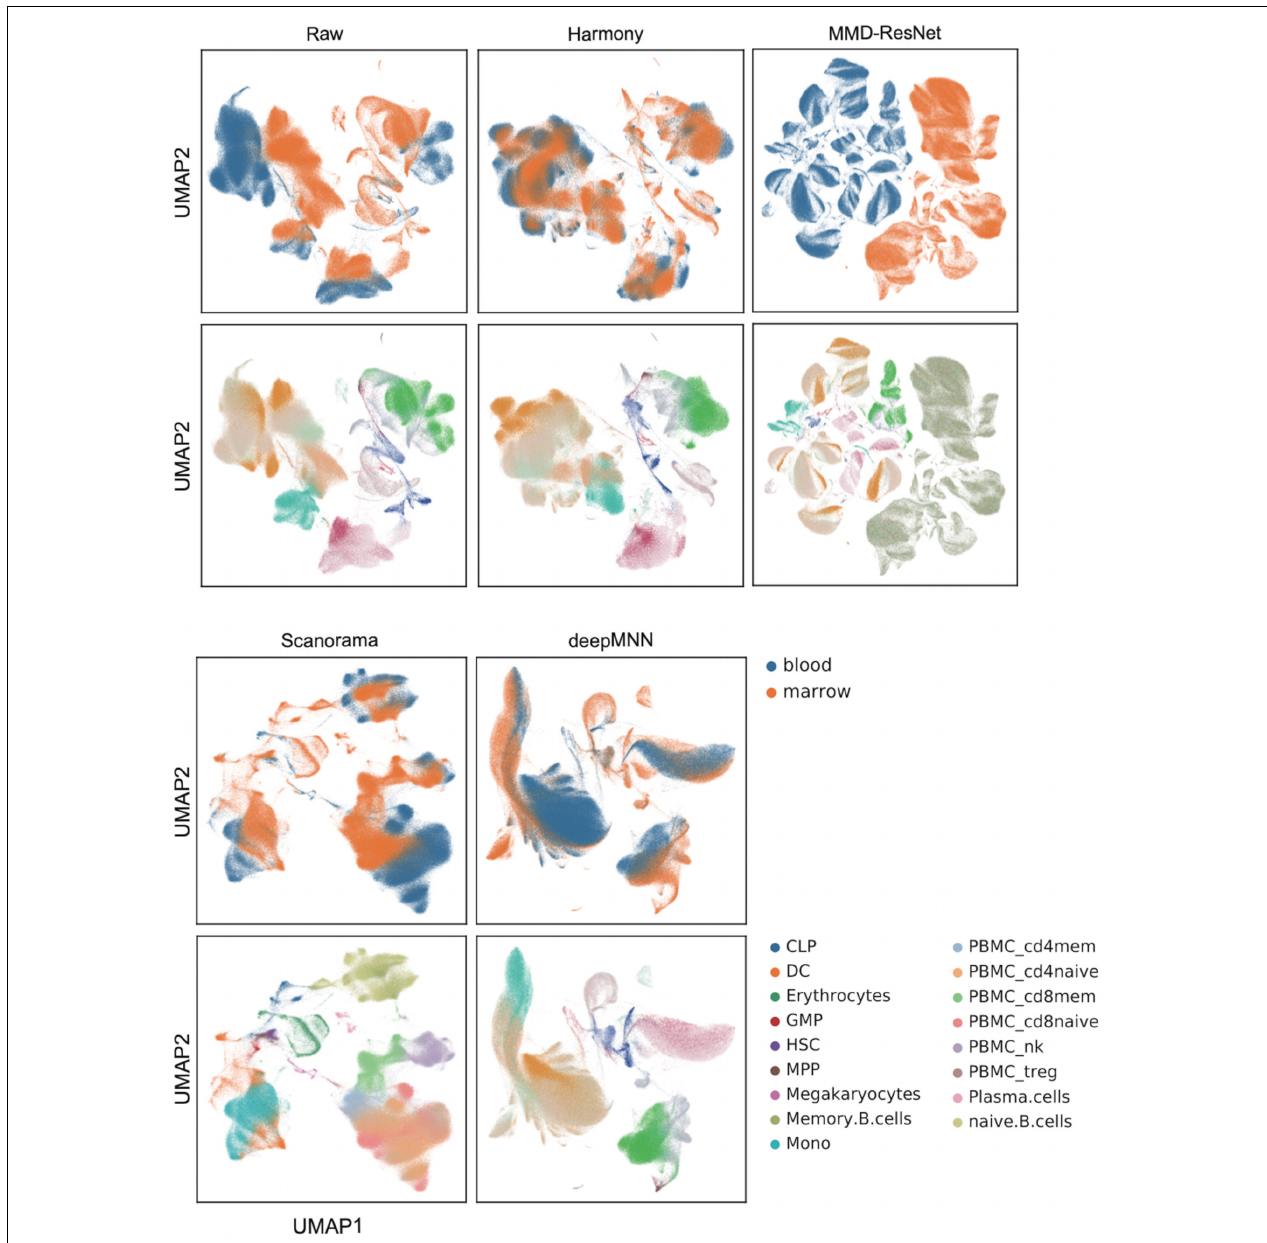
FIGURE 6 | Evaluation of raw data, Harmony, MMD-ResNet, Scanorama, scGen, and deepMNN on the large-scale HCA dataset with 528,014 cells. The cells were colored by batches on the top row and colored by cell type on the bottom